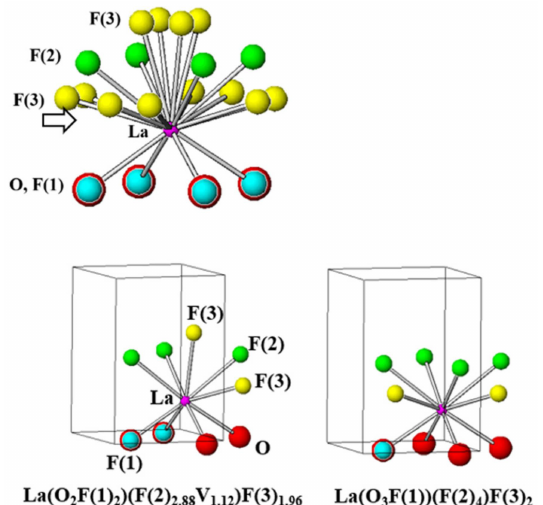
Figure 2. Polyhedrons of LaO 0.65 F 1.7 , 9-coordinated La(O 2 F(1) 2 )(F(2) 2.88 V 1.12 )F(3) 1.96 , and 10-